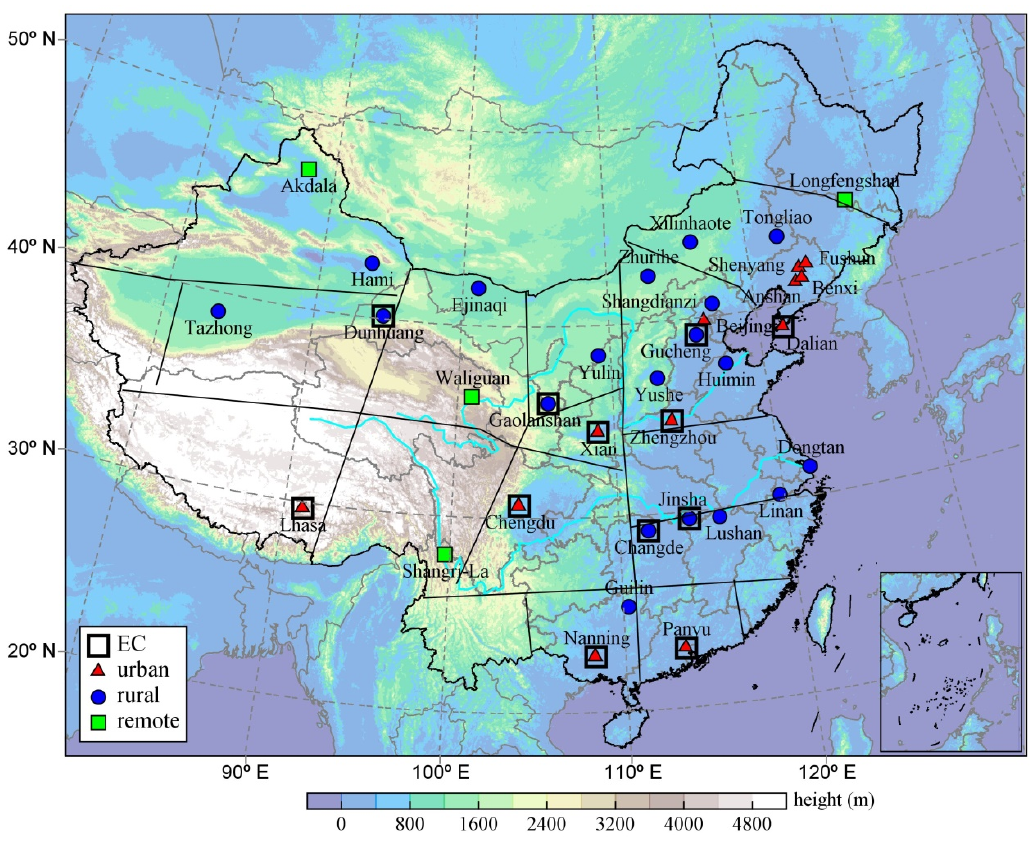
Figure 1. Sites distribution of the China Atmosphere Watch Network (CAWNET) and the nine regions in China comes from the work of Zhang et al. [31] .